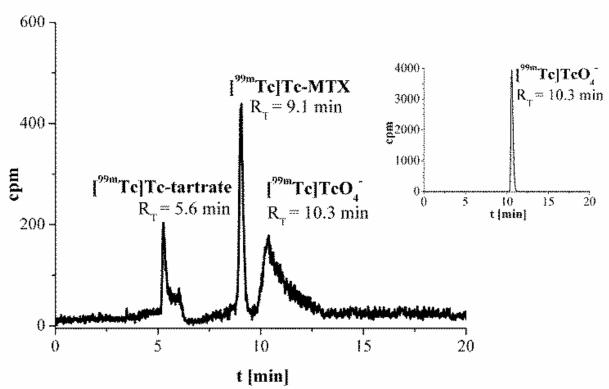
Figure 10. Radiochromatogram of aqueous phase of the [ 99m Tc]Tc-MTX reaction mixture recorded after lipophilicity